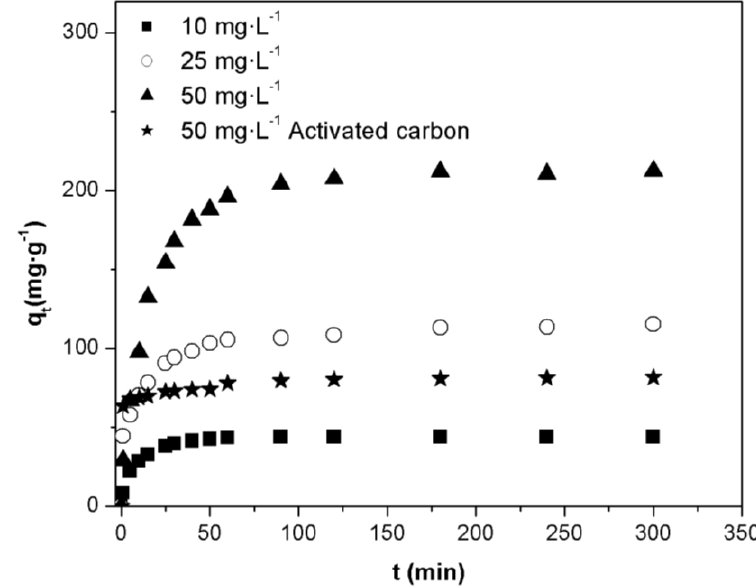
Figure 4. Effect of contact time and initial dye concentration on the adsorption of Orange II onto Fe(BTC) (adsorbent mass:10 mg; temperature: 308 K; pH